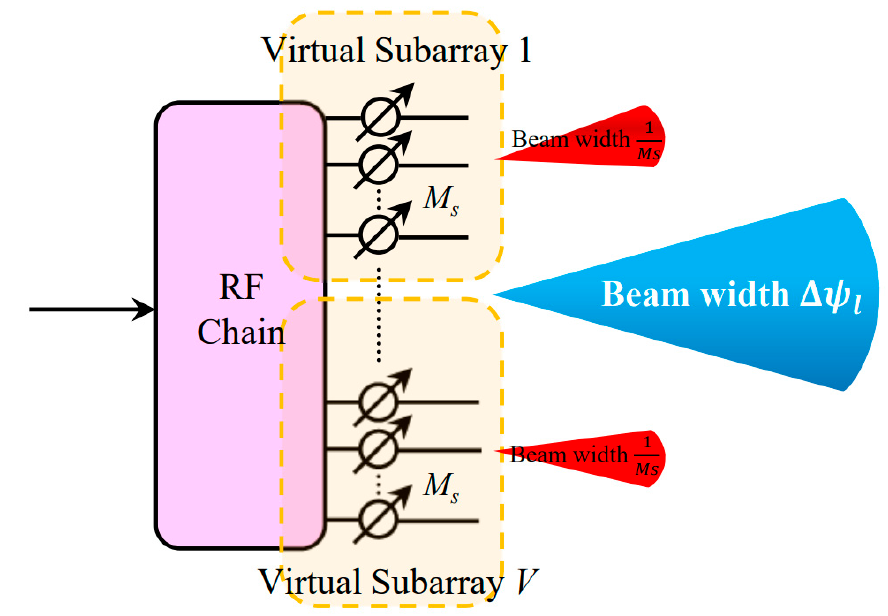
Figure 12. Diagram of the proposed subarray design [59].